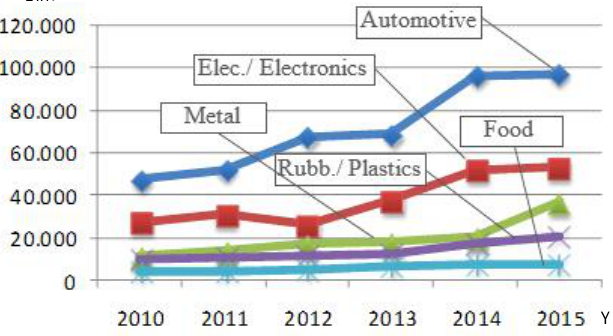
inh . Fig. 4: The application of industrial robots worldwide by industry in period 2010-2015 on annual basis